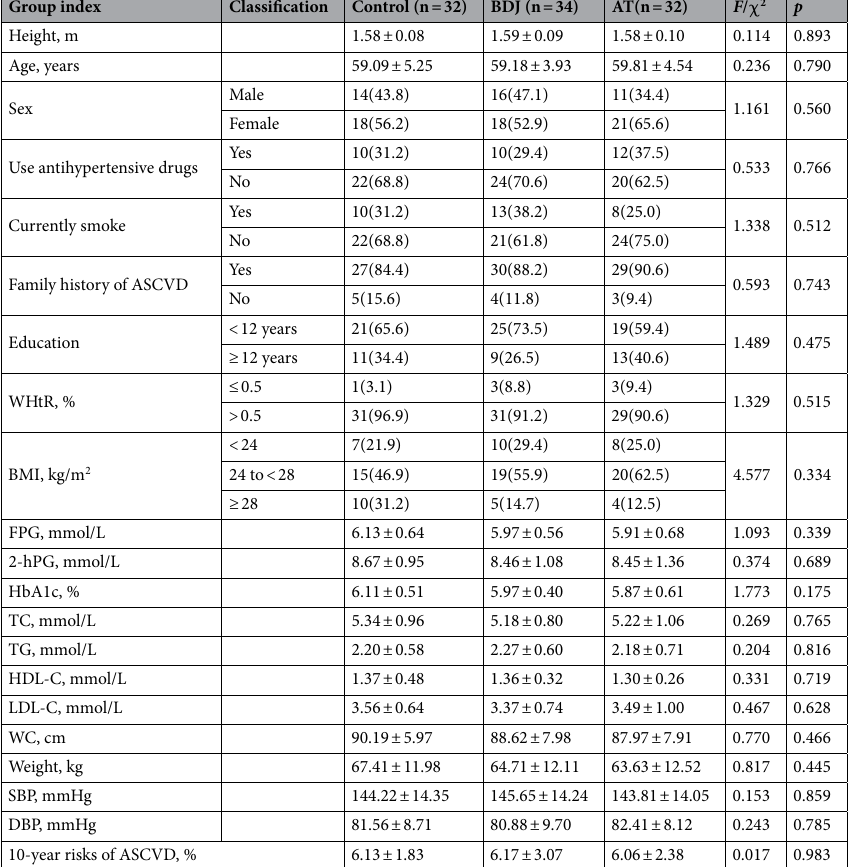
Table 1. Comparison of baseline demographic characteristics among groups [mean ± SD or n (%)]. BDJ, Baduanjin; AT, aerobic training; FPG, fasting plasma glucose; 2-hPG, 2-h plasma glucose; HbA1c, haemoglobin A1c; TC, total cholesterol; TG, triglycerides; HDL-C, high-density lipoprotein cholesterol; LDL- C, low-density lipoprotein cholesterol; WC, waist circumference; SBP, systolic blood pressure; DBP, diastolic blood pressure; ASCVD, atherosclerotic cardiovascular disease; WHtR, waist-to-height ratio; BMI, body mass